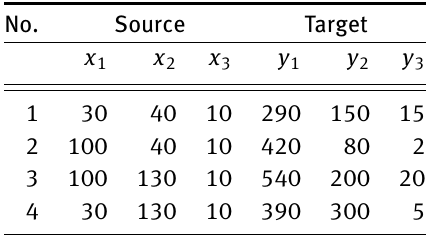
Table 1: Example of a 3D similarity transformation: coordinates